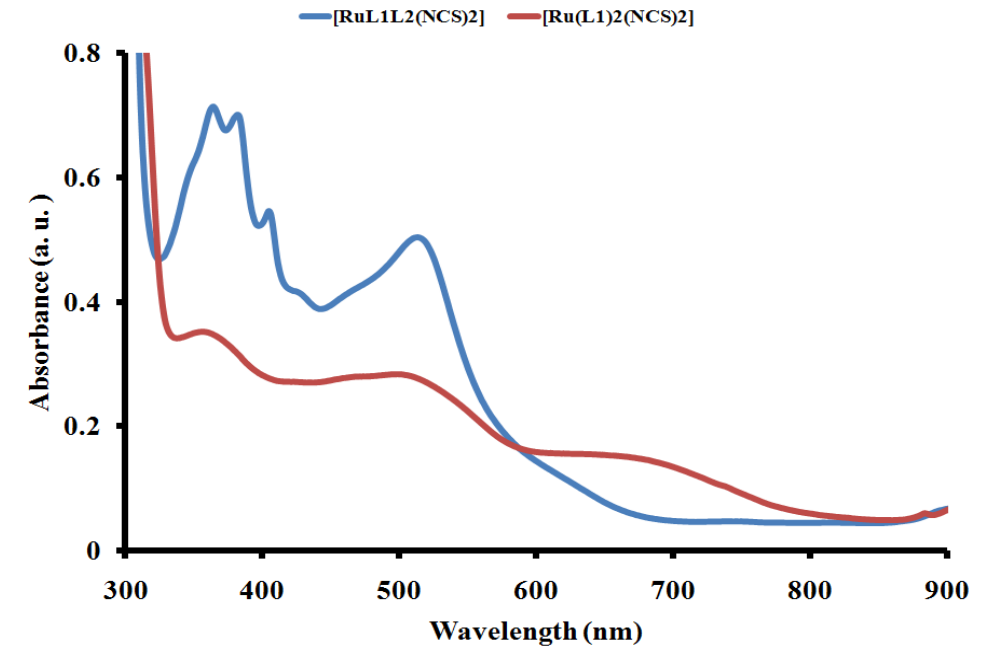
Figure 3. Comparison of the UV-Vis absorption spectrum of [RuL and [Ru(L ) (NCS) ] (red line) at a concentration of 1 × 10 − 3 M − 1 in DMF solution 1 2 2 showing effect of extended π -conjugation using